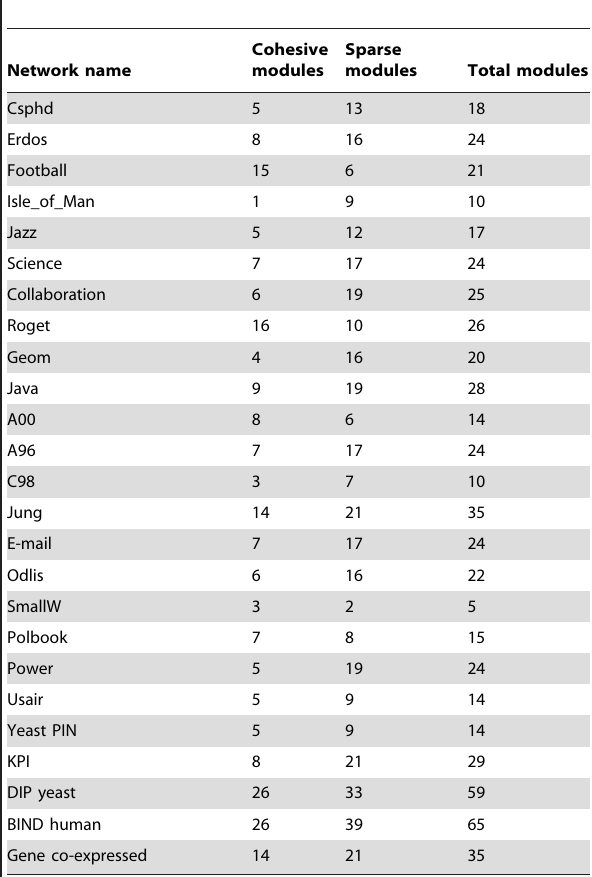
Table 4. List of modules detected by BTS method in 25 complex networks.